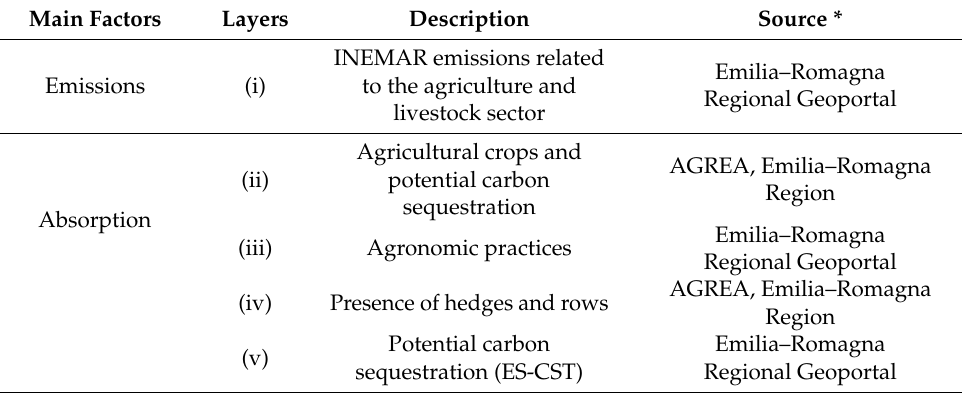
Table 1. Information layers and related elements identified.